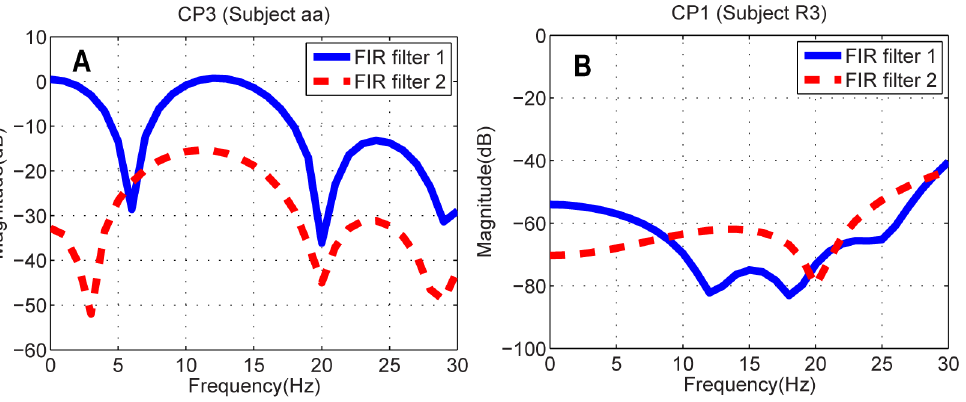
Figure 3. The frequency responses of FIR filters in Subject aa’s CP3 and Subject R3’s CP1. FIR filter 1 and FIR filter 2 correspond to the highest and the lowest eigenvalues, respectively.